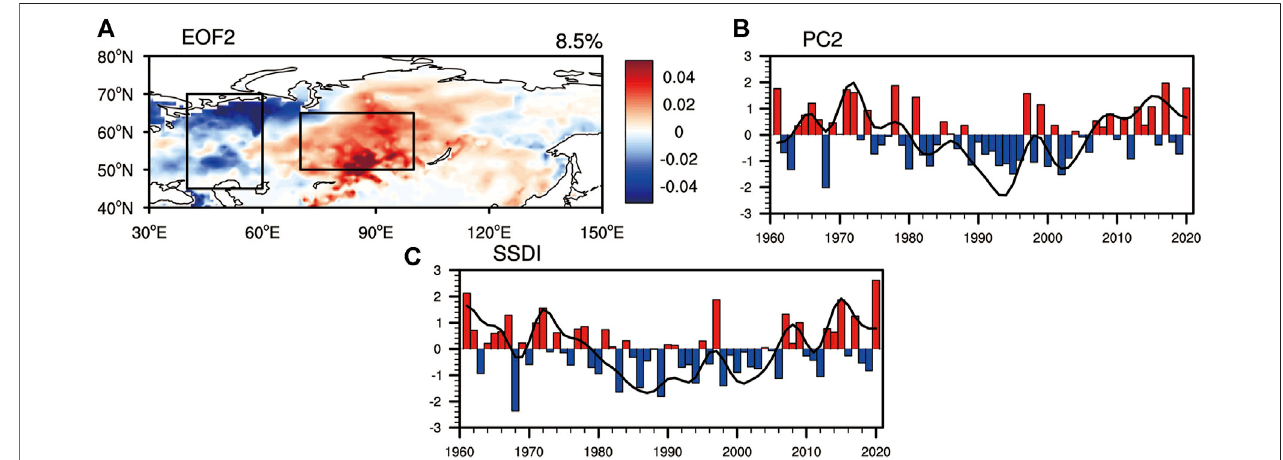
FIGURE 1 | (A) Spatial pattern of the second mode of empirical orthogonal function (EOF2) and (B) the corresponding standardized time series of the second principal component (PC2) of Eurasian SSD during 1961 – 2020. (C) Same as (B) , but for the difference of SSD between the rectangles with positive values (50 ° – 65 °